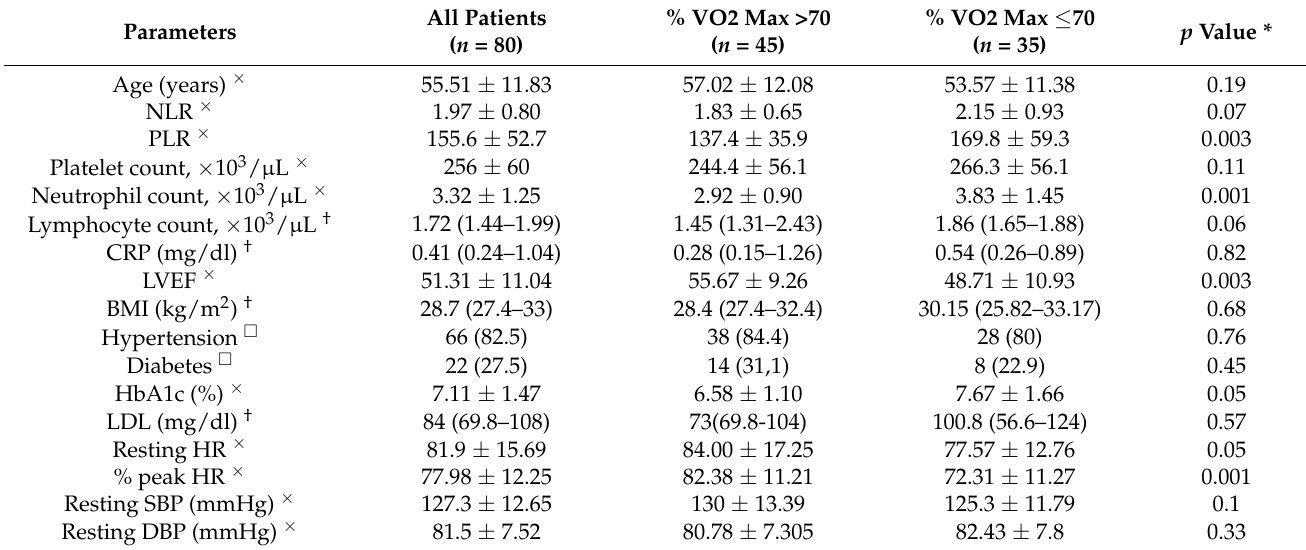
Table 1. Univariate analysis of the two groups according to the values of % VO2 max in all study